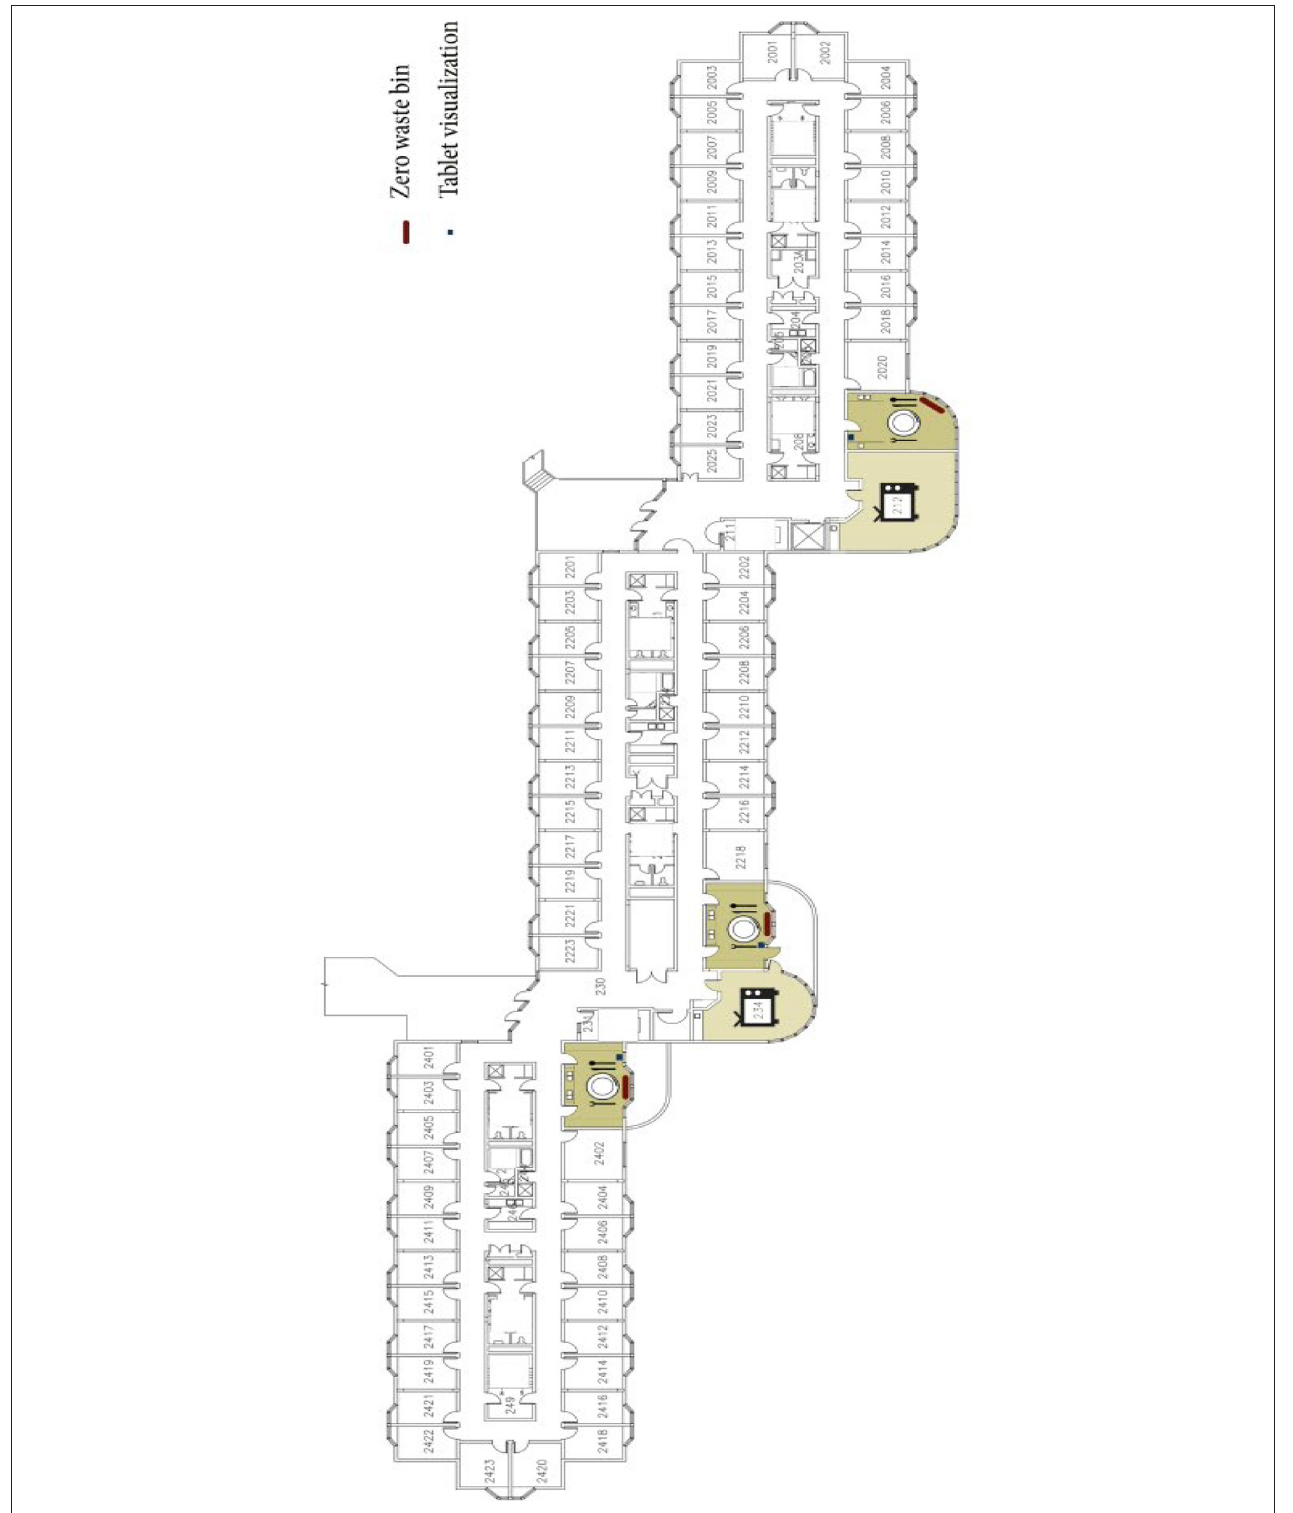
FIGURE 3 | A floor plan of the second level of McTaggart-Cowan Hall of the Simon Fraser University.